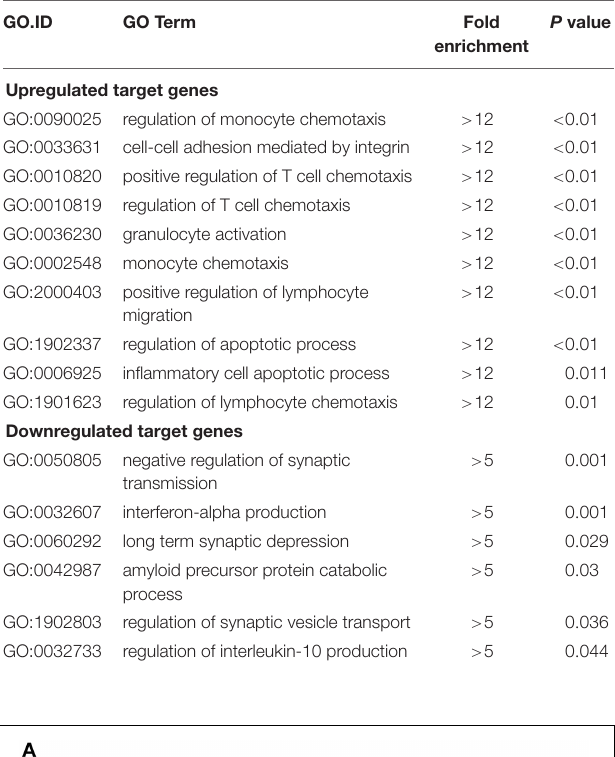
TABLE 1 | Top 10 differentially expressed lncRNAs. Top 10 differentially expressed lncRNAs (Surgery vs. Control)